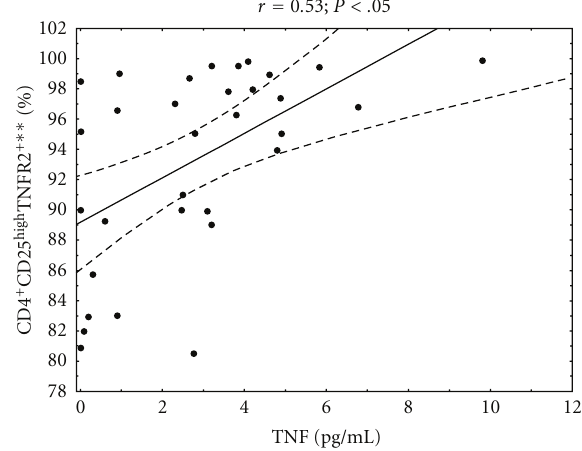
Figure 5: Relationship between the percentage of CD4 + CD25 high TNFR2 + regulatory T cells and serum TNF level in analyzed DM1 subjects. The level of TNF was measured in serum of diabetic type 1 patients and correlated with the percentage of peripheral blood regulatory T cells carrying TNFR2 in these patients. The Spearman test was used to calculate the strength of correlation ( r = 0 . 5; P < . 05). ∗∗ The percentage of cells among CD4 + CD25 high